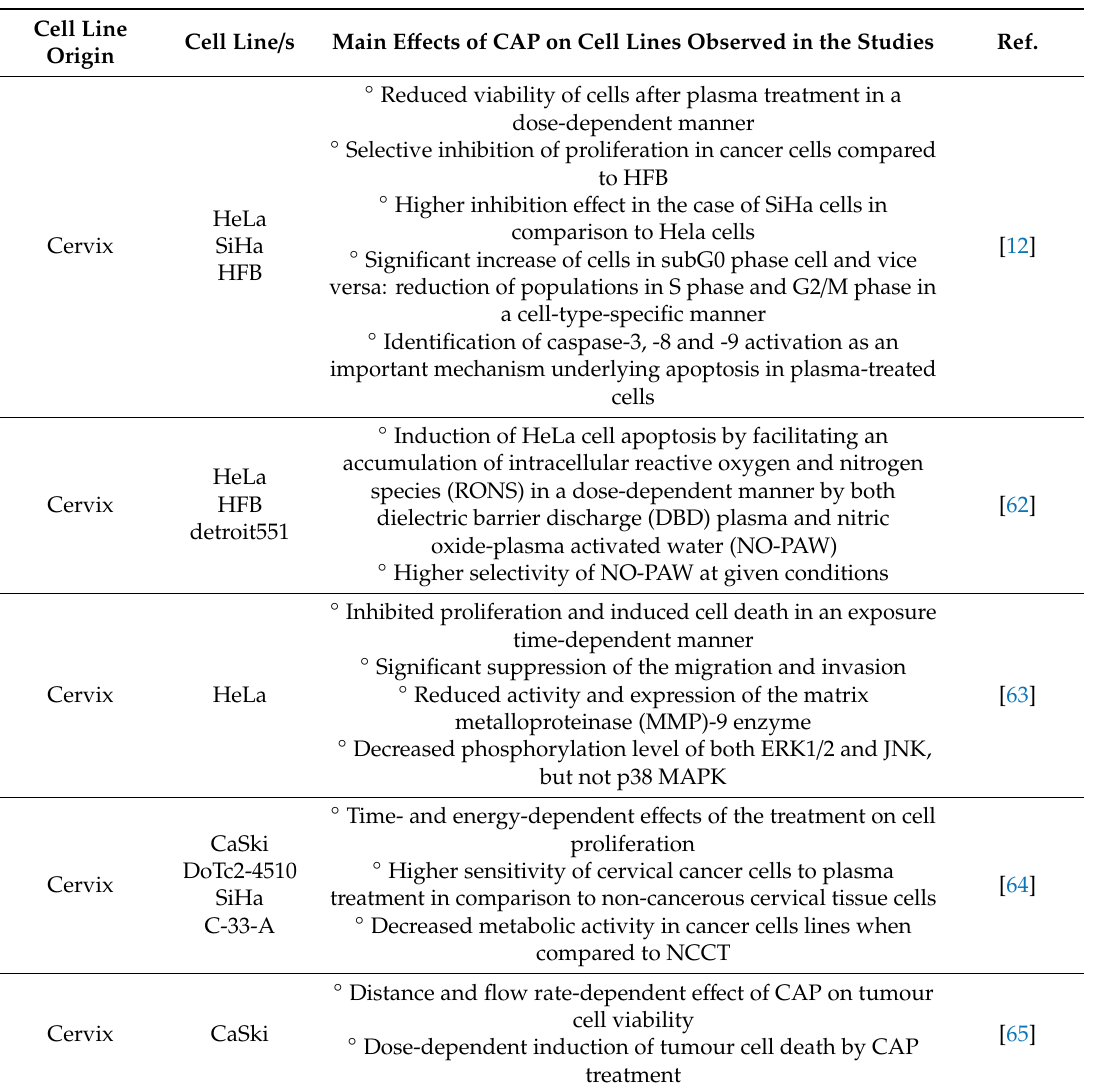
Table 1. Overview on available studies of cold atmospheric plasma (CAP) in gynaecologic cancer cell lines. Cell Line / s Main E ff ects of CAP on Cell Lines Observed in the Studies